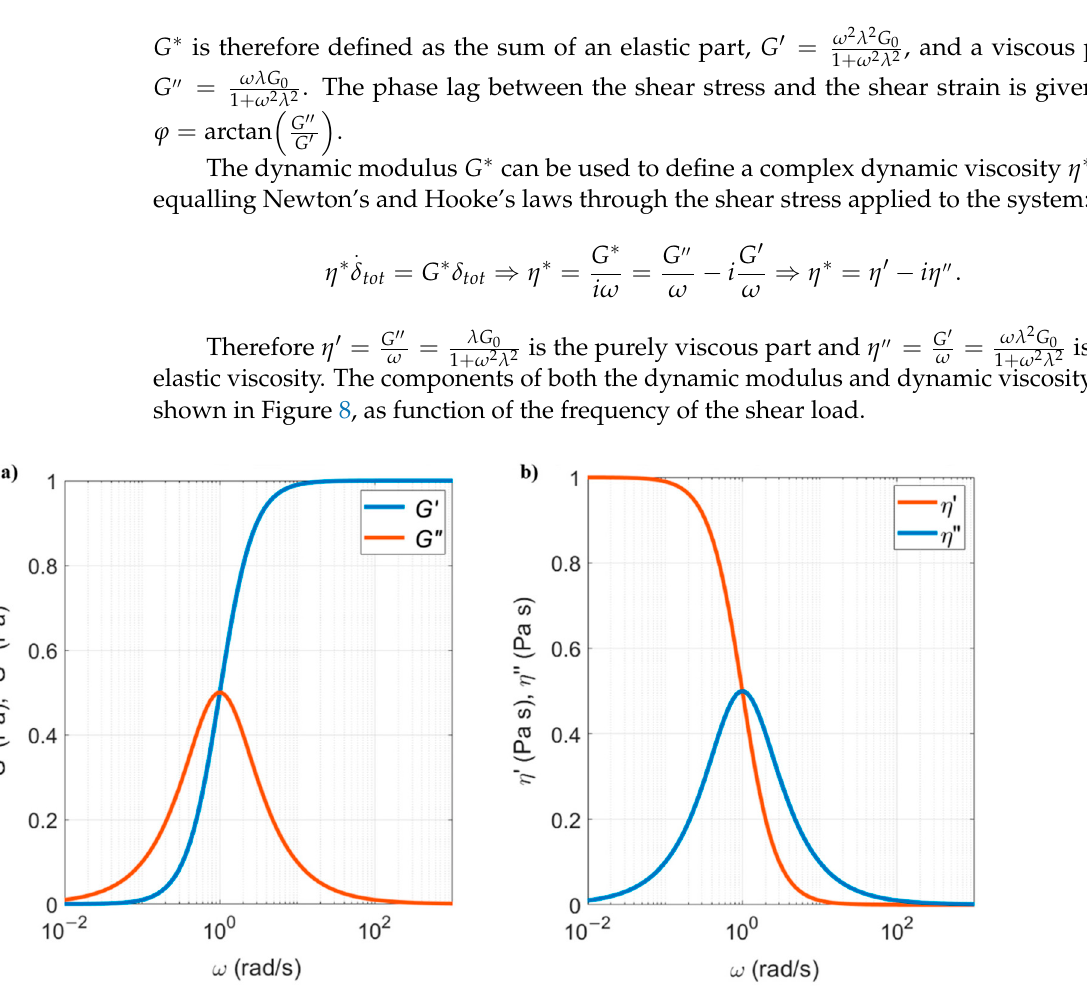
Figure 8. ( a ) Elastic (real) and viscous (imaginary) parts of the dynamic elastic modulus; ( b ) viscous (real) and elastic (imaginary) parts of the complex viscosity for λ = 1 s, G 0 = 1 Pa, and η = 1 Pa s in a Maxwell